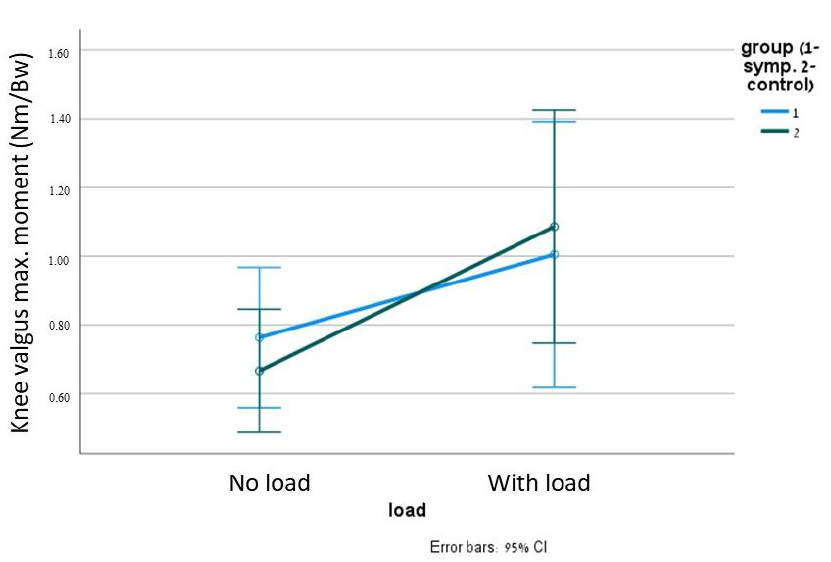
Table 5. Spatiotemporal parameters according to research groups and load condition. PFPS Group (N = 10)